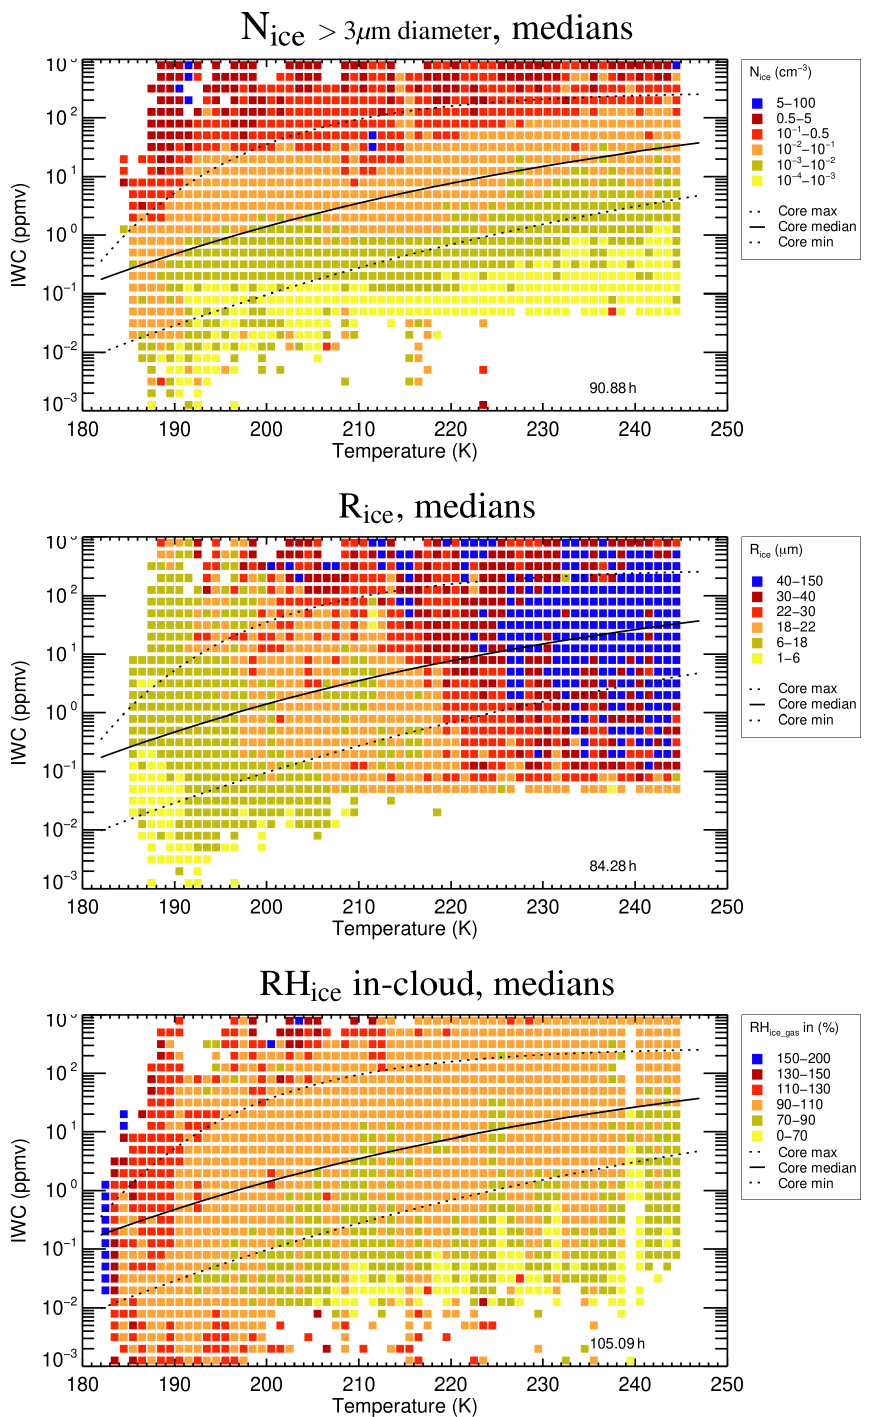
Figure 6. Median N ice , R ice , and RH ice in intervals in the IWC– T parameter space (five IWC intervals per order of magnitude, 1K temper- ature intervals). The color codes of N ice and RH ice range from yellow to blue with increasing amount of the respective parameter; for R ice , the color code is reversed to indicate that high and low N ice values belong to small and large R ice . Black solid and dotted lines: median, min, and max IWC of the core IWC band of Schiller et al. (2008). The variability of the parameters (25th, 50th (median), and 75th percentiles) is shown in Figs. S1–S3 of the